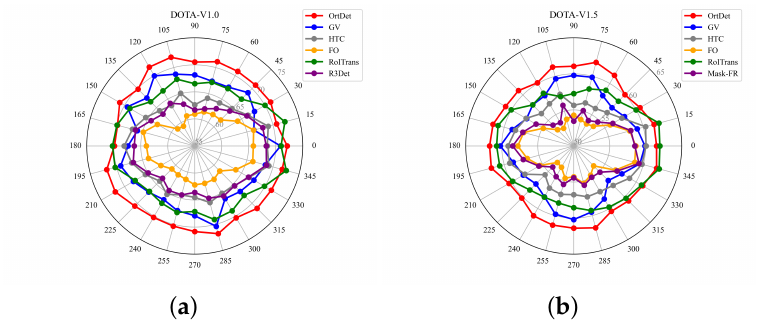
Figure 13. A higher roundness of the curve indicates a higher robustness of the detector, and a smaller distance between the curve and the outer circle indicates higher accuracies. ( a ) Variation of the detection accuracy with the rotation angle of the validation set on the DOTA-v1.0 dataset. ( b ) The variation of the detection accuracy with the rotation angle of the validation set on the DOTA-v1.5